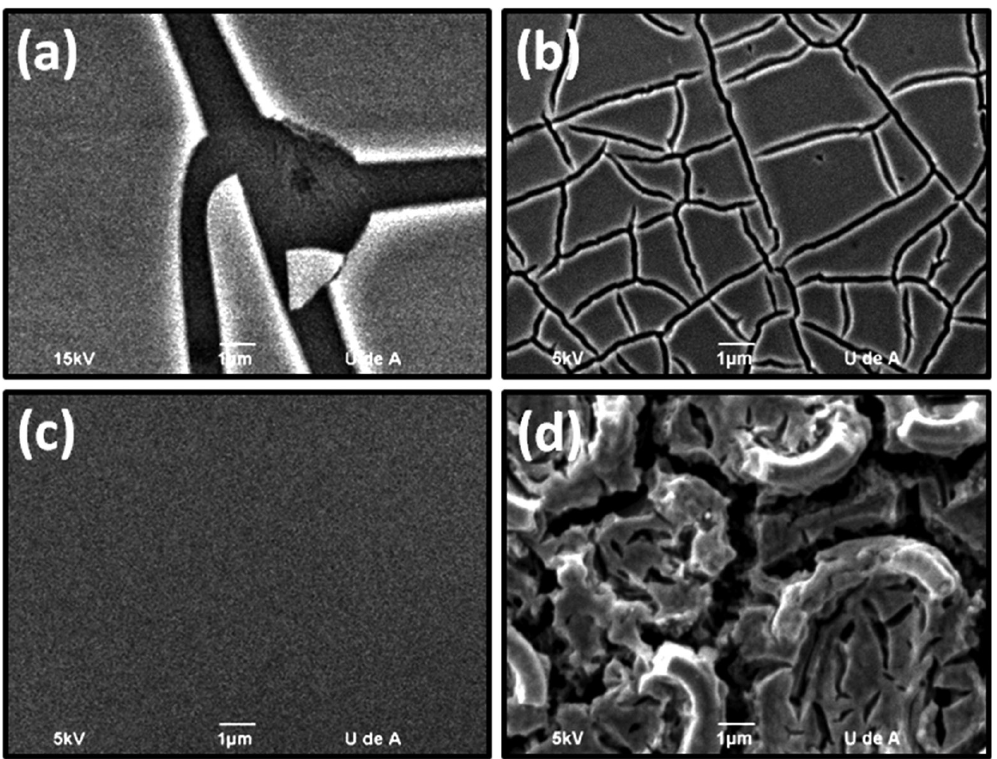
Figure 4. SEM images of the surface of the TiO